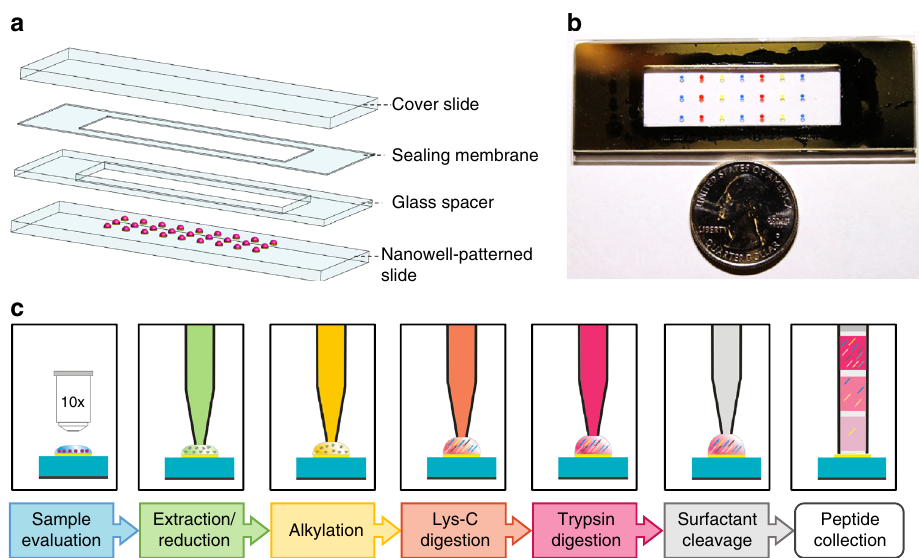
Fig. 1 Proteomic sample preparation with nanoPOTS. a Schematic drawing and ( b ) photograph showing the nanoPOTS chip with each nanowell fi lled with 200 nL of colored dye. The cover slide can be removed and resealed for dispensing and incubation. c One-pot protocol for proteomic sample preparation and capillary-based sample